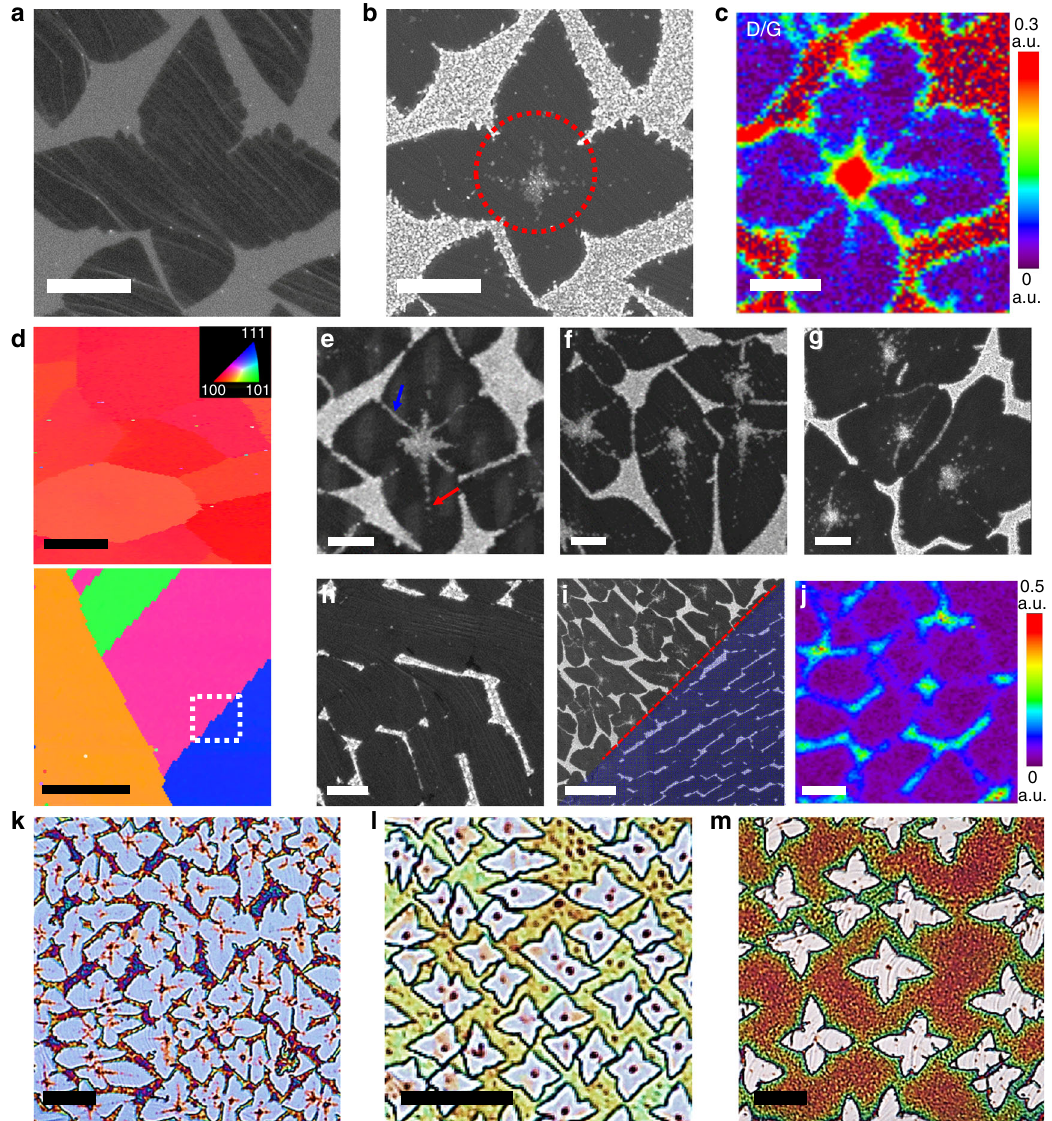
Fig. 2 Different oxidation behaviors of various microscopic graphene defects in graphene islands depending on variables. Representative SEM images of Gr islands grown on a Cu foil at 1000 °C for 1 min a before and b after annealing at ~200 °C for 70 min in air (scale bar = 3 µ m). c A typical Raman D/G map image of the as-synthesized Gr islands transferred onto SiO 2 /Si (scale bar = 3 µ m). d Typical EBSD map images of the Cu foil after Gr islands were grown at 1000 °C, followed by the annealing process at ~200 °C for 120 min in air (scale bar = 50 µ m). The EBSD data show that the Cu foils consist of grains mostly with orientations of approximately (100) (upper) and, in some regions, grains with orientations of (111) and (101), as well as high-index orientations (bottom). e – i Representative SEM images of the annealed Gr islands grown on Cu grains with an orientation of e , f (100), g (101), h (111), and i the boundary region between (100) and (111) (indicated by the white-dotted square in Fig. 2d). Scale bars, 2 µ m e – h , 10 µ m i . j A typical Raman D/G map image of the Gr islands grown on a Cu(111) grain transferred onto SiO 2 /Si (scale bar = 2 µ m). k – m OM images of the Gr islands grown on Cu(100) grains after annealing at ~200 °C for 120 min under various CVD growth conditions. The Gr islands were grown k at ~1050 °C for 30 s under CH 4 (10 sccm) and H 2 (5 sccm), l at ~1000°C for 30 s under CH 4 (10 sccm) and H 2 (20 sccm), and m at ~1,000 °C for 3 min under CH 4 (2 sccm) and H 2 (5 sccm). The